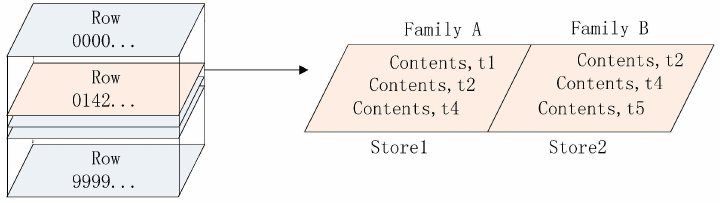
Figure 3. Vertical partitioning in